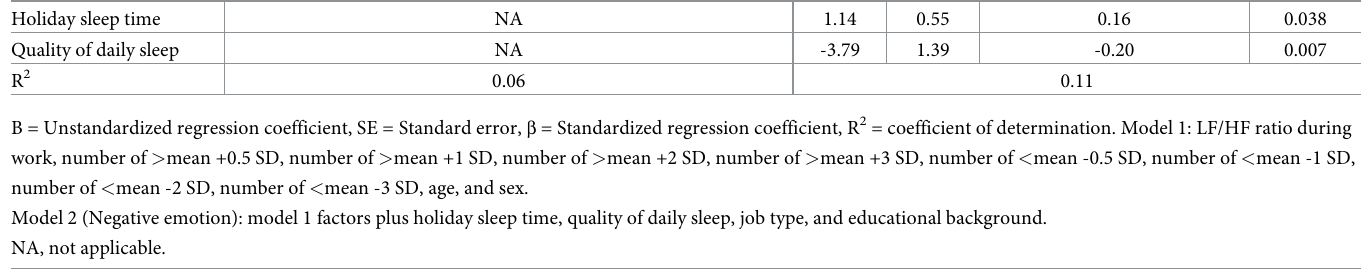
effect on a low FS score (Table 6). Next, as model 2, demographic characteristics were added to the above-mentioned variables related to the LF/HF ratio, sex, and age. Poor sleep quality ( β = 0.37), low household income ( β = 0.24), and a high mean LF/HF ratio at work ( β = -0.19) (R 2 = 0.23) had an effect on a low SWLS (Table 3). The number of times the mean LF/HF ratio exceeded +3 SD ( β = -0.16), Poor